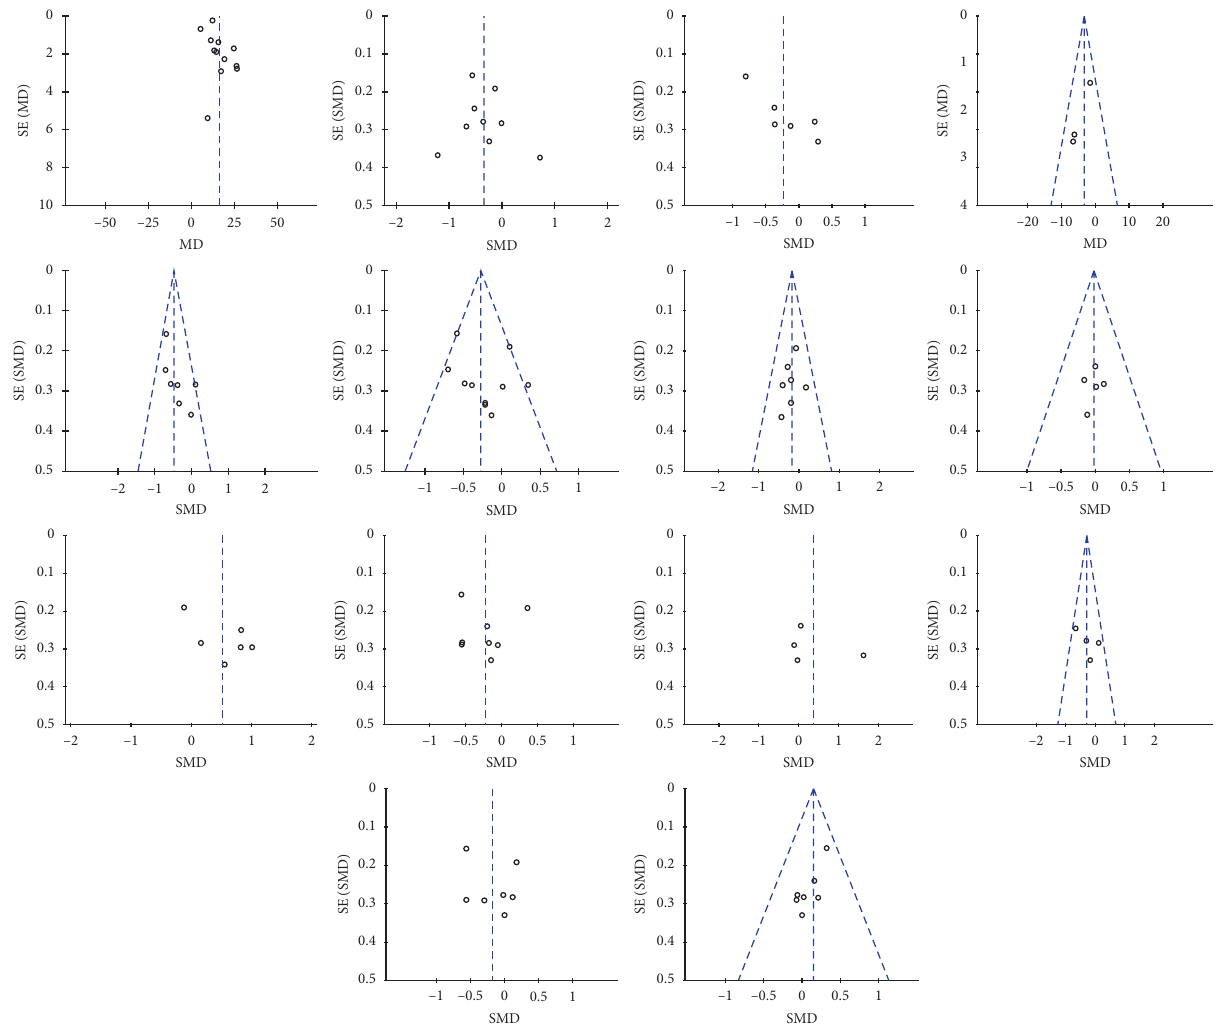
Figure 8: Funnel plot of standard error by standard differences in the means of plasma: (a) vitamin D; (b) FPG; (c) fasting insulin; (d) HOMA-IR; (e) QUICKI; (f) triglycerides; (g) total-C; (h) HDL-C; (i) LDL-C; (j) VLDL-C; (k) total testosterone; (l) DHEAS; (m) SHBG; (n) hs-CRP in selected trials.